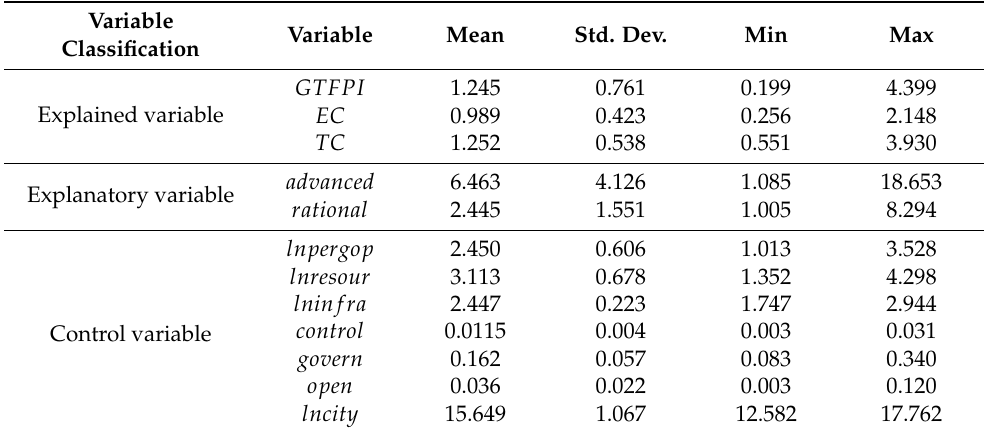
Table 1. Descriptive Statistics of